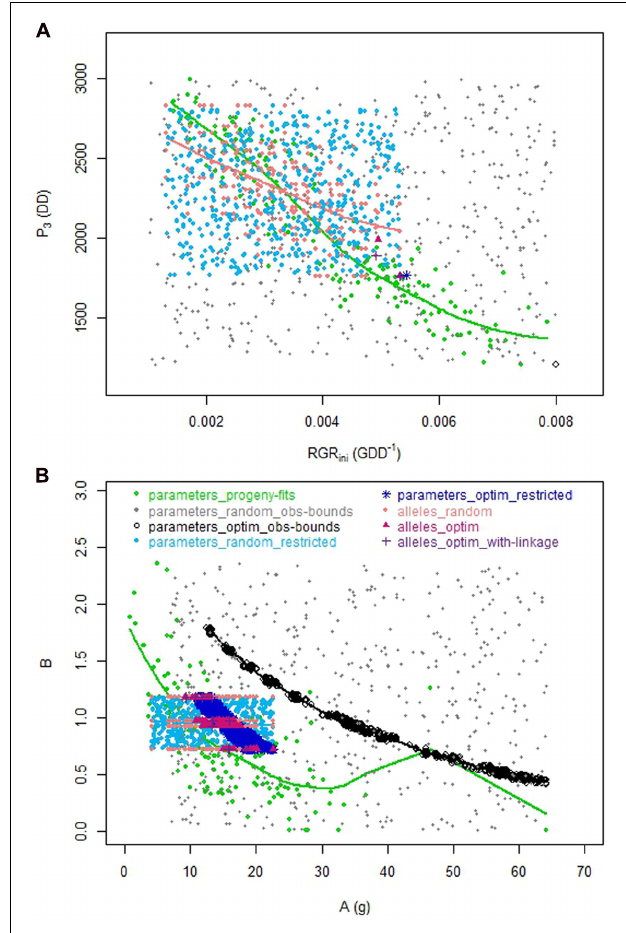
FIGURE 4 | Relationships between parameters for the eight datasets. (A) Relationship between P 3 and RGR ini . (B) Relationship between A and B